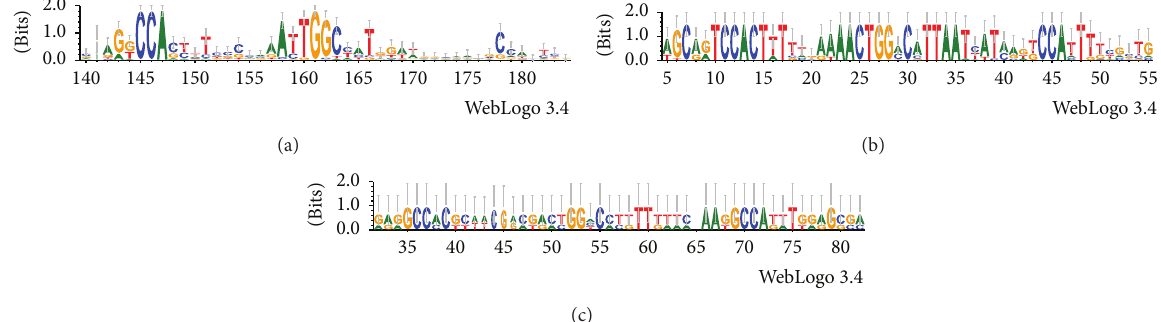
Figure 8: Logos of the alignments of the promoter regions. Logos of the alignments of the promoter regions from (a) Actinobacteria, (b) Gammaproteobacteria, and (c) Alphaproteobacteria regulons. The height of symbols (each one representing a nucleotide) within the stack indicates the observed frequency of the corresponding nucleotide at that position. 𝑥 -axis indicates the sequence position in the corresponding nucleotide